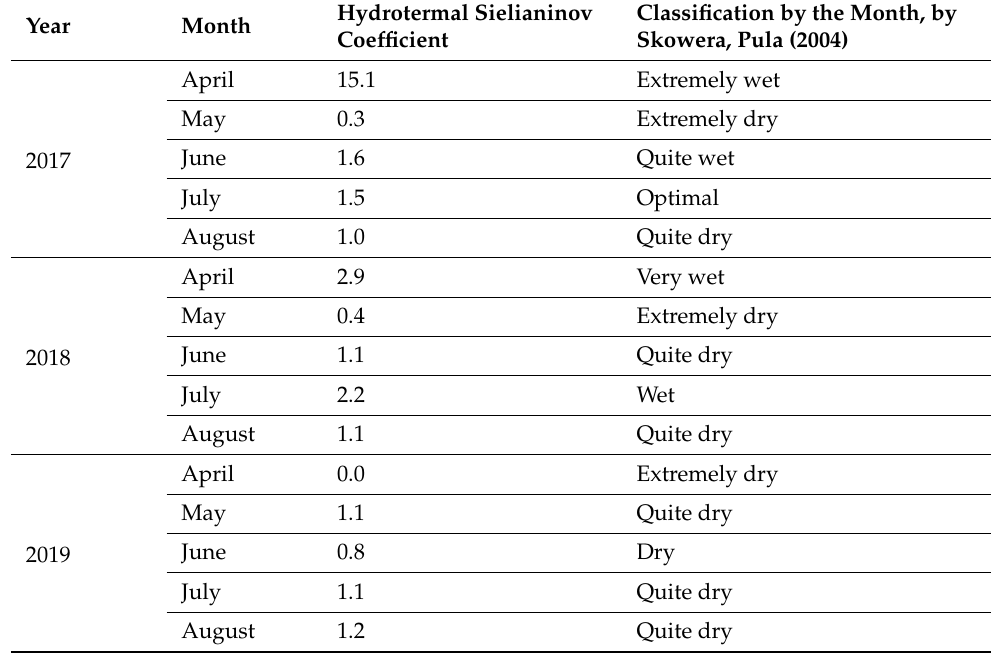
Table 8. Sielianinov coefficient during vegetation period of mint in 2017—2019. Hydrotermal Sielianinov Classification by the Month, by Year Month Coefficient Skowera, Pula (2004) April 15.1 Extremely wet May 0.3 Extremely dry June 1.6 Quite wet 2017 July 1.5 Optimal August 1.0 Quite dry April 2.9 Very wet May 0.4 Extremely dry June 1.1 Quite dry 2018 July 2.2 Wet August 1.1 Quite dry April 0.0 Extremely dry May 1.1 Quite 2019